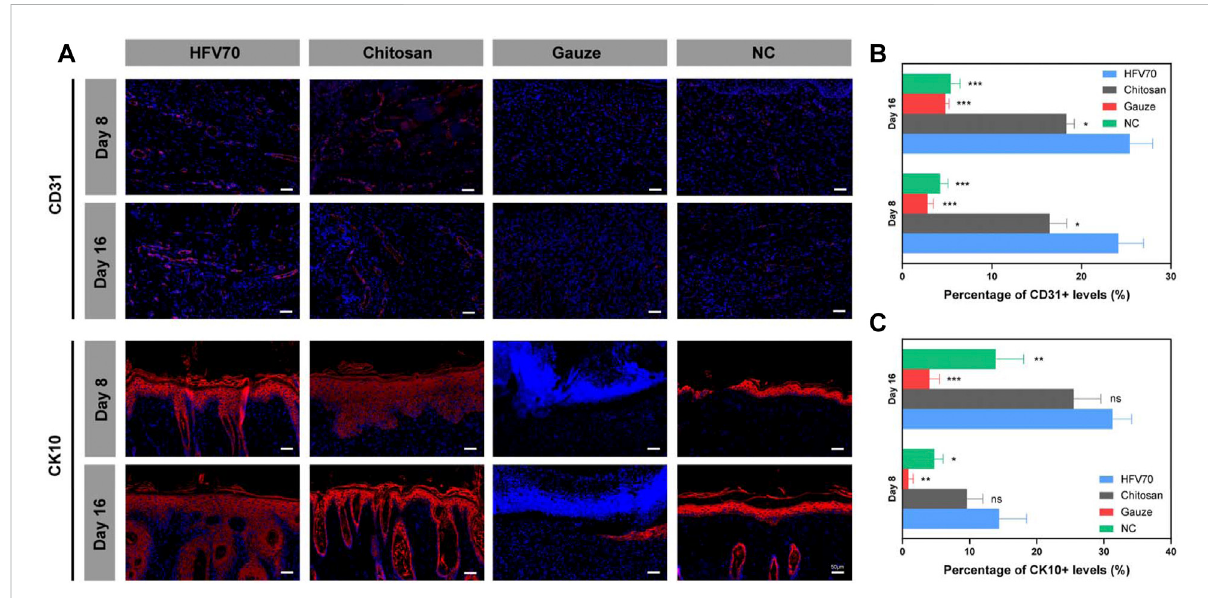
FIGURE 8 Immuno fl uorescence analysis of wound tissues. (A) Representative images of regenerated skin tissues stained with anti-CD31, anti-CK10 (red), and DAPI (blue). (B) Analysis of positive staining ratios of CD31 in the healing wound sections. (C) Analysis of positive staining ratios of CK10 in the healing wound sections. * p < 0.05; ** p < 0.01; *** p < 0.001; *comparing to the HFV70